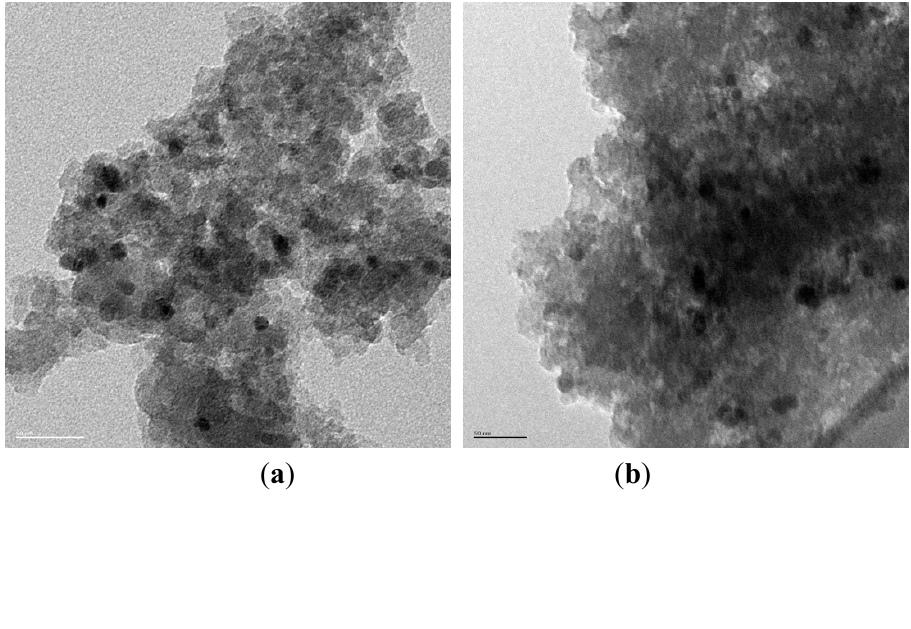
Figure 5. TEM micrographs of magnetically separable heterogeneous base